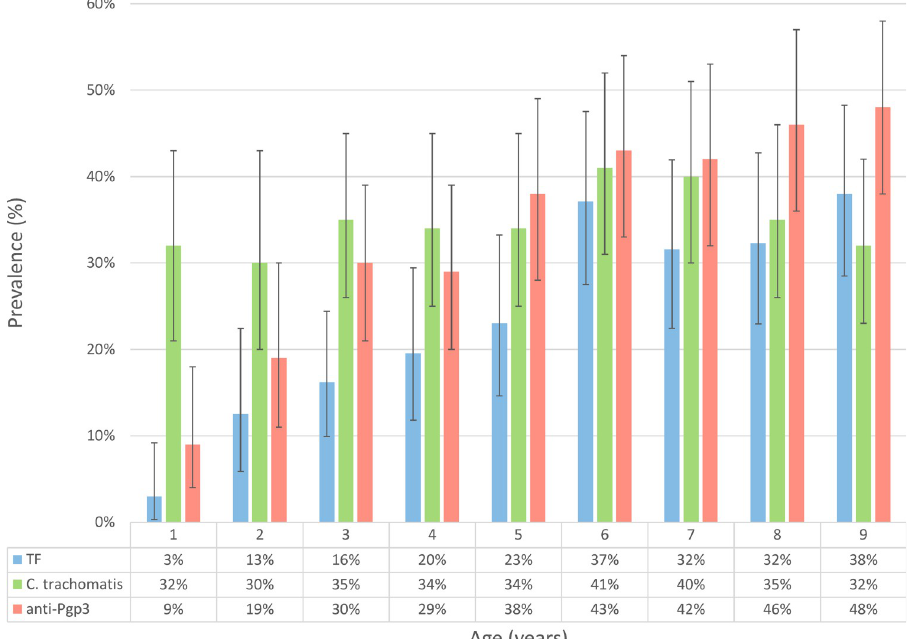
Fig 2. Prevalence of trachomatous inflammation—follicular, ocular Chlamydia trachomatis detection, and anti- Pgp3 antibodies in examined children aged 1–9 years in Nauru, July 2019. Abbreviations: TF, trachomatous inflammation—follicular. Error bars showing 95% confidence intervals around survey prevalence estimate for each outcome.